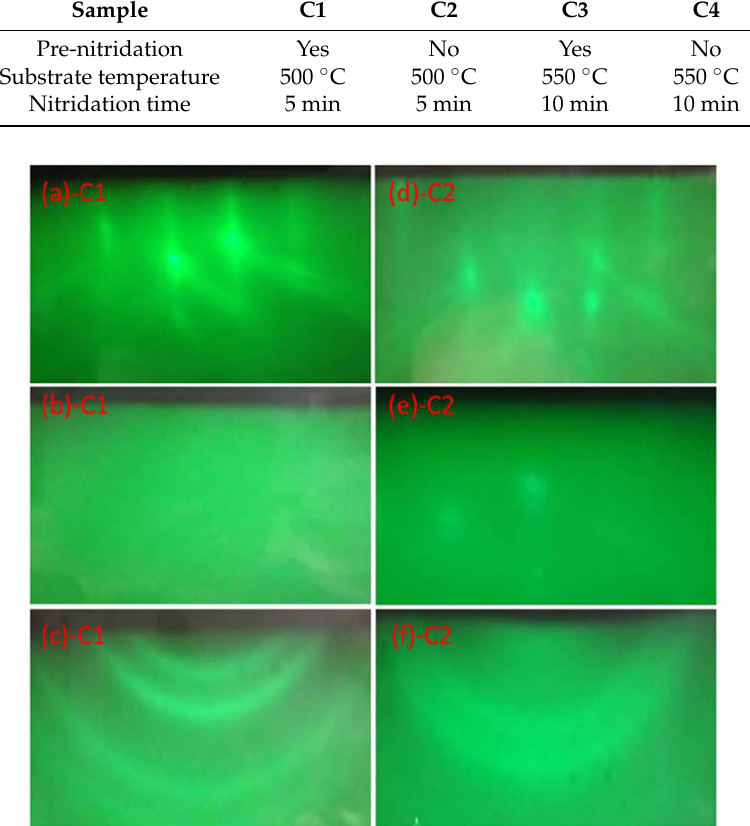
Figure 1. In ‐ situ reflection high ‐ energy electron diffraction (RHEED) observations: ( a ) C1 sample Figure 1. In-situ reflection high-energy electron diffraction (RHEED) observations: ( a ) C1 sample after after thermal cleaning, ( b ) C1 sample after pre ‐ nitridation on Si surface, ( c ) C1 sample after thermal cleaning; ( b ) C1 sample after pre-nitridation on Si surface; ( c ) C1 sample after nitridation nitridation process (i.e., the formation of GaN nanodots), ( d ) C2 sample after thermal cleaning, ( e ) process (i.e., the formation of GaN nanodots); ( d ) C2 sample after thermal cleaning; ( e ) C2 sample after C2 sample after Ga droplets, and ( f ) C2 sample after nitridation process (i.e., the formation of GaN nanodots). Ga droplets; and ( f ) C2 sample after nitridation process (i.e., the formation of GaN